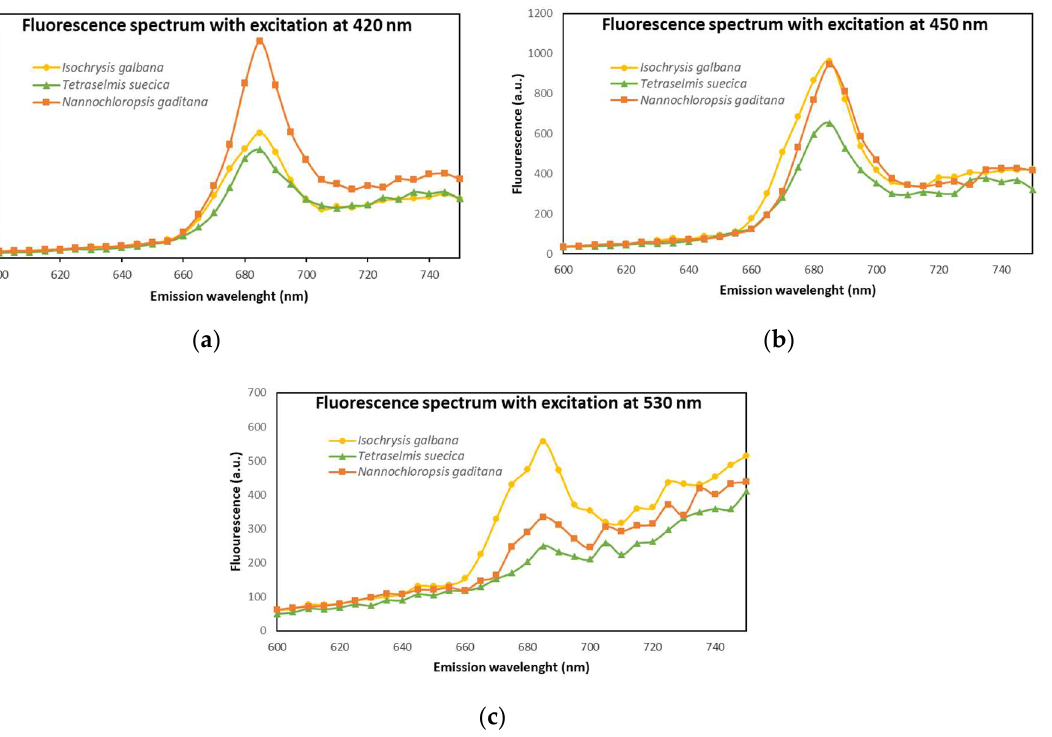
Figure 6. Fluorescence spectrum with excitation at: ( a ) 420 nm; ( b ) 450 nm; ( c ) 530 nm. The maximum standard deviation ( n = 3) of 5% was obtained.